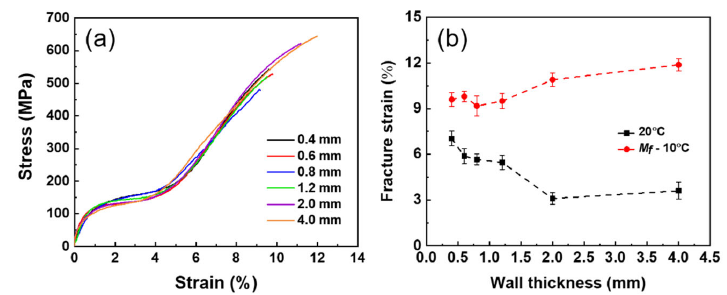
Figure 9. ( a ) The tensile stress–strain curves of the samples fabricated with 800 mm/s tested at 10 °C below the martensite transformation finish temperature ( M f )’ corresponding test temperatures were − 30, − 15, − 45, − 46, − 54, and − 58 °C as the wall thickness increased, respectively; ( b ) the comparison of the fracture strain and fracture stress tested at 20 °C and M f − 10 °C corresponding to ( a ) (the error bars are derived from repeated experiments under the same